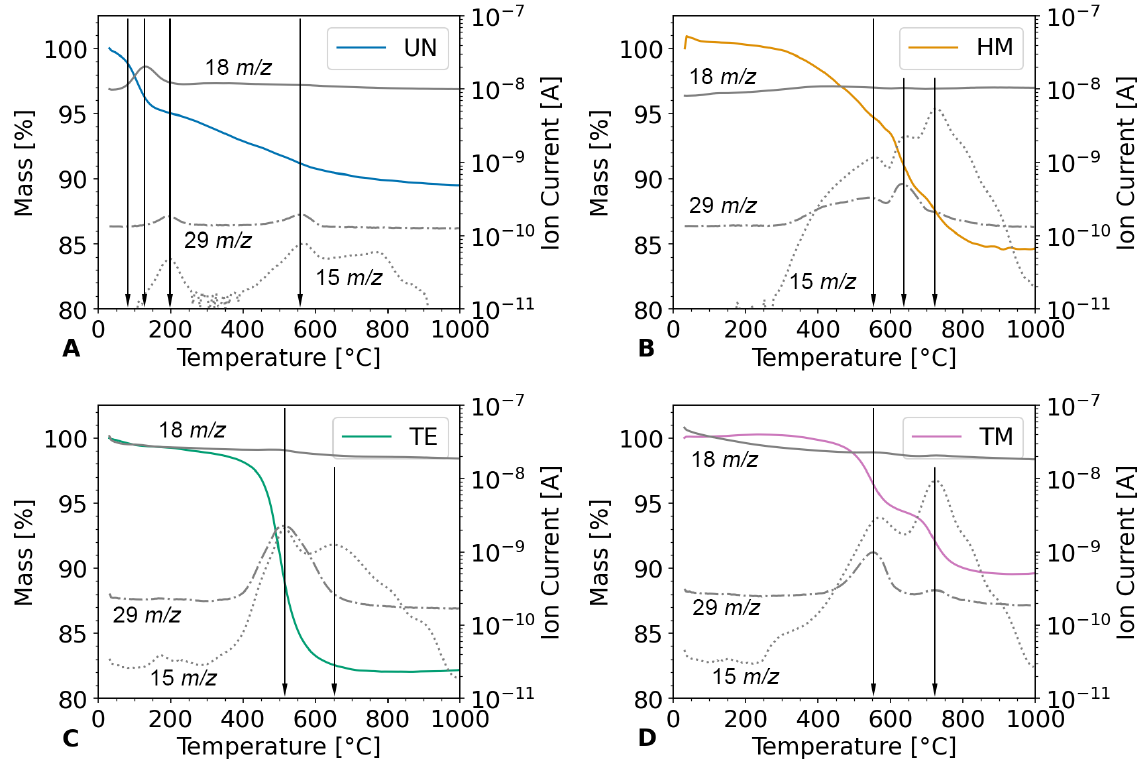
Figure 4. TGA measurements coupled with MS for the ( A ) unmodified UN (blue), ( B ) hexamethyldisilazane-modified HM (orange), ( C ) triethylchlorosilane-modified TE (green), and ( D ) trimethylchlorosilane-modified TM samples (pink). The ion current of the MS measurement is shown for selected molecular weights of 18 m / z (solid), 15 m / z (dot), and 29 m / z (dash-dot). A vertical black line was drawn to highlight changes in the MS measurements.